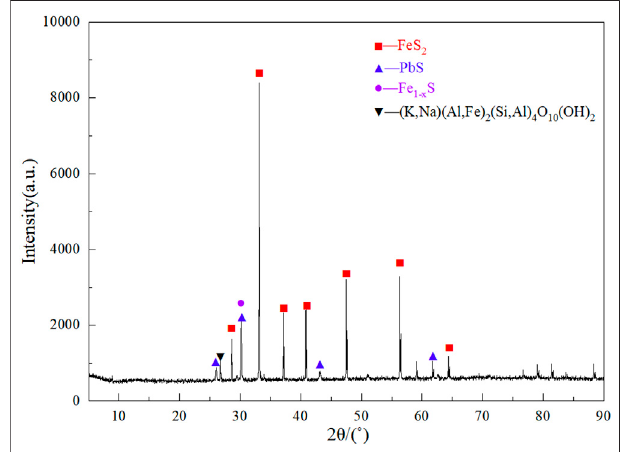
FIGURE 1 | XRD diffractograms of telluride-type gold